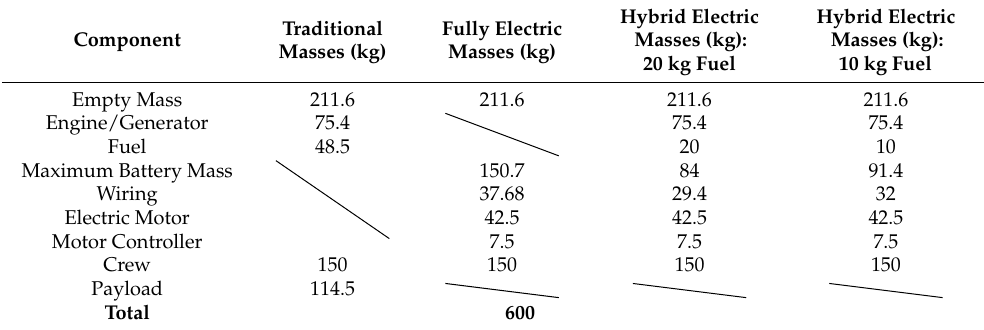
Table 1. Traditional, fully electric, and hybrid electric powertrain aircraft mass breakdowns.